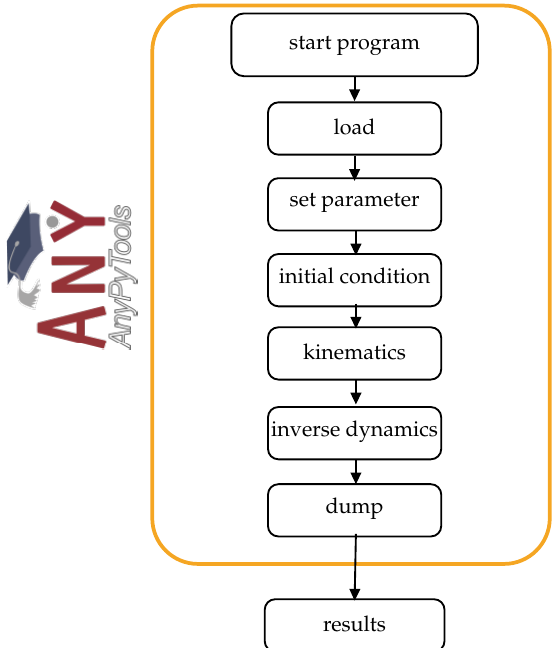
Figure 7. The Python library AnyPyTools can be used to control the AMS. Various actions can be performed using Python and AnPyTool: start the AMS, load the simulation model, set parameter, set the model to its initial conditions, start the kinematic, and inverse dynamics analysis and dumping the result values (source: AnyPyTool logo [30]).